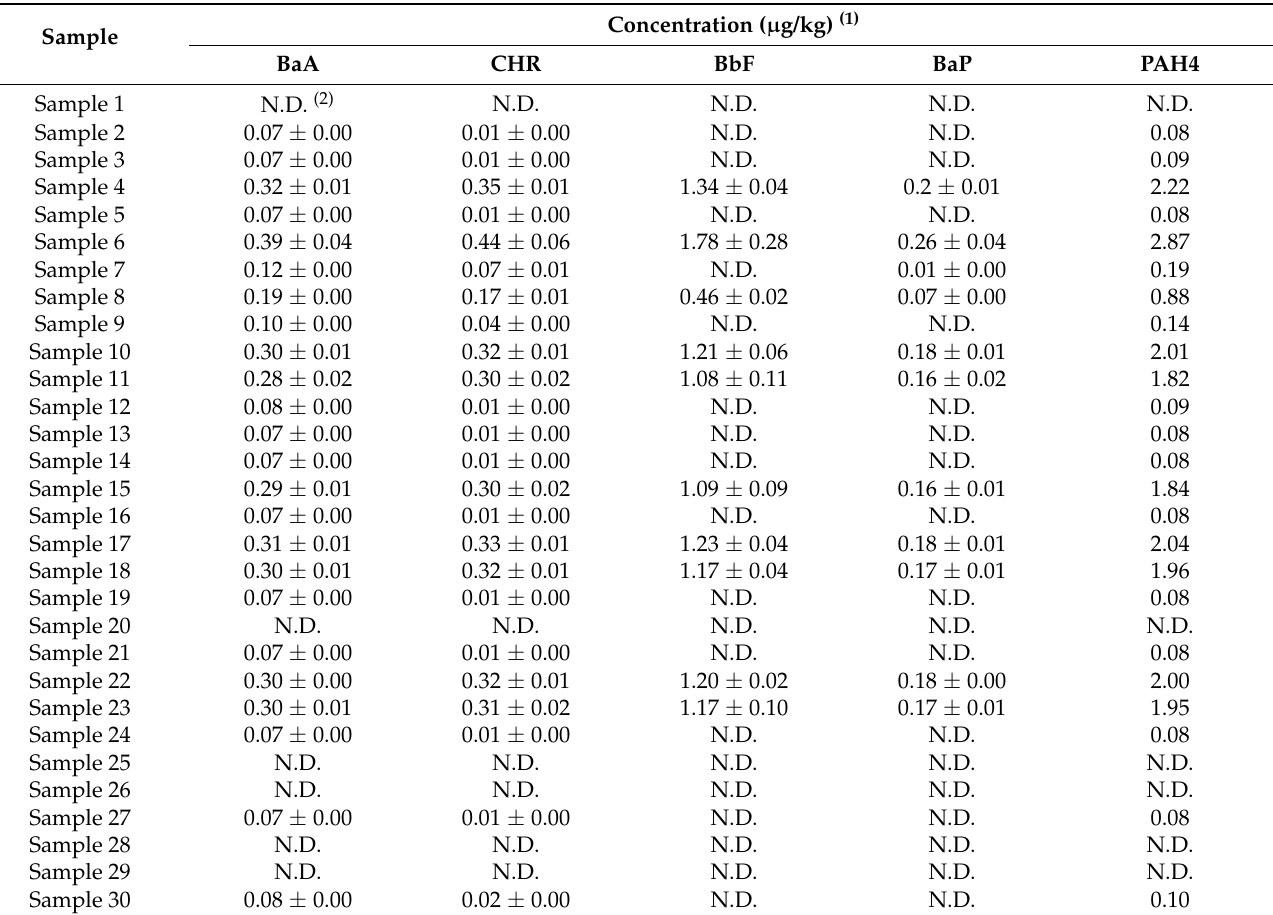
Table 3. PAH4 concentration in herbal medicines analyzed using typical pretreatment